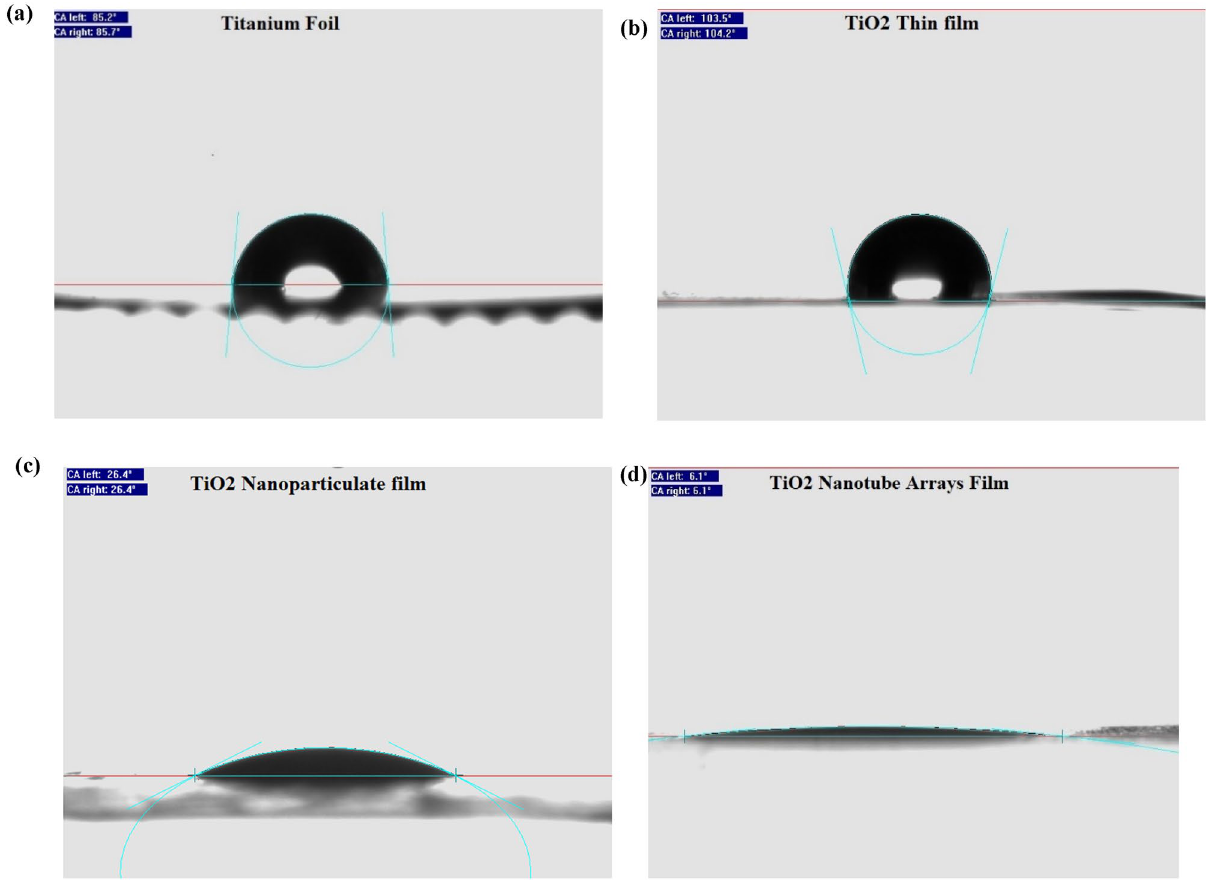
Figure 6. Measurement of the water contact angle on the triboelectric films for ( a ) Ti foil, ( b ) TiO 2 Thin film, ( c ) TiO 2 nanoparticulate film, and ( d ) TiO 2 nanotube